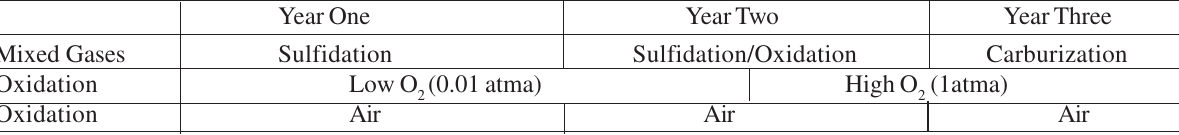
Table 2. Test Plan for conditions being used to generate corrosion